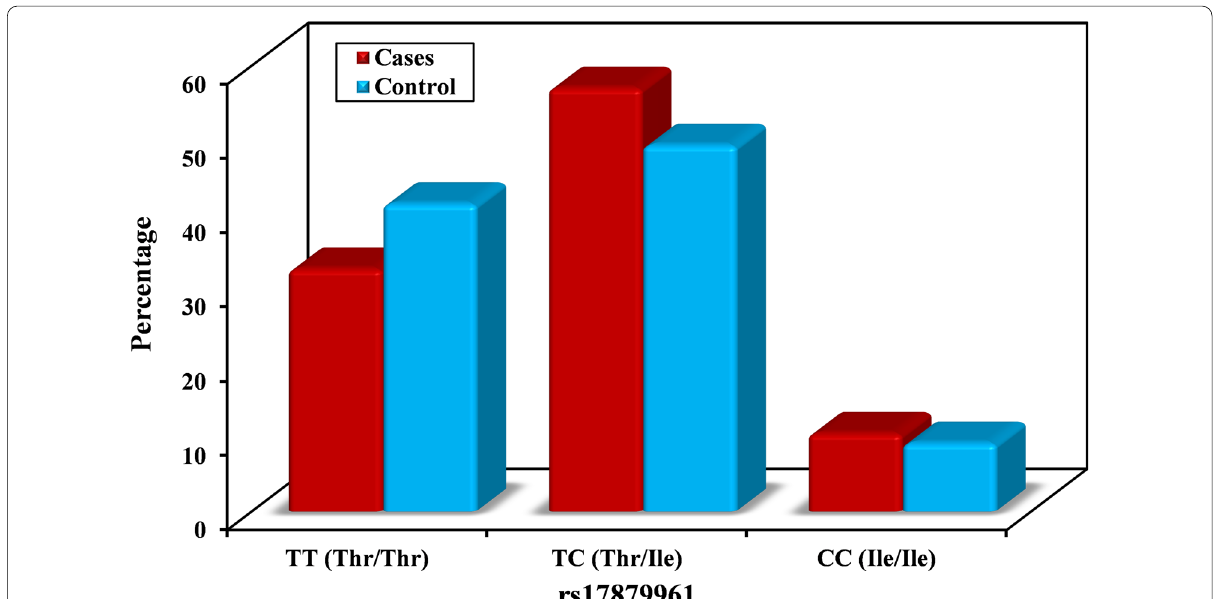
Fig. 1 The genotype distribution of rs17879961 polymorphisms among cases and control